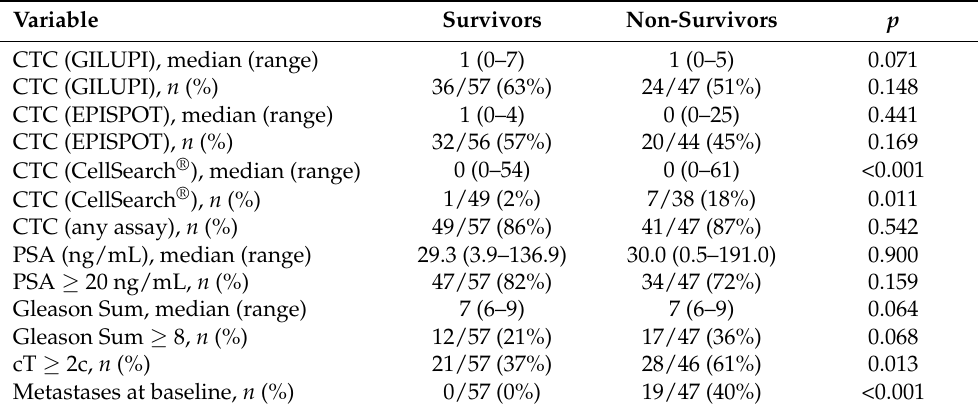
Table 5. Univariate and multivariate analyses for OS in 104 patients with high-risk PCa.